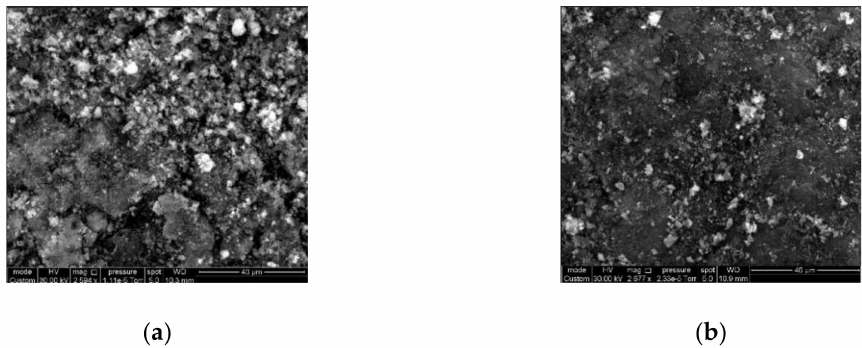
Figure 1. Scanning electron microscopy (SEM) images of the peat-derived AC-4 ( a ) and AC-6 ( b ) adsorbents. The scale bar is 40 µ m.